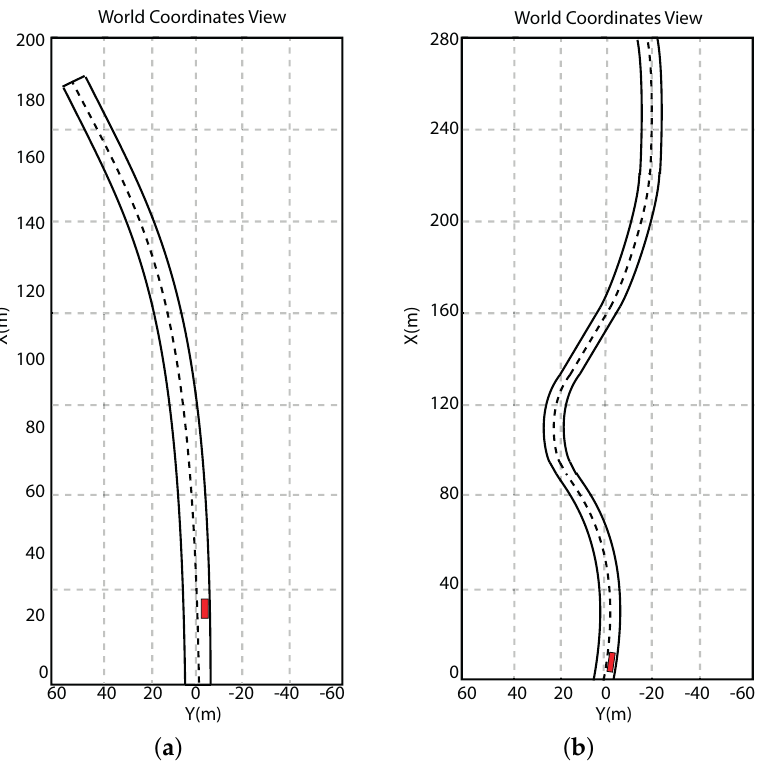
Figure 15. Simulation scenarios: scenario 1 ( a ) and scenario 2 ( b ).